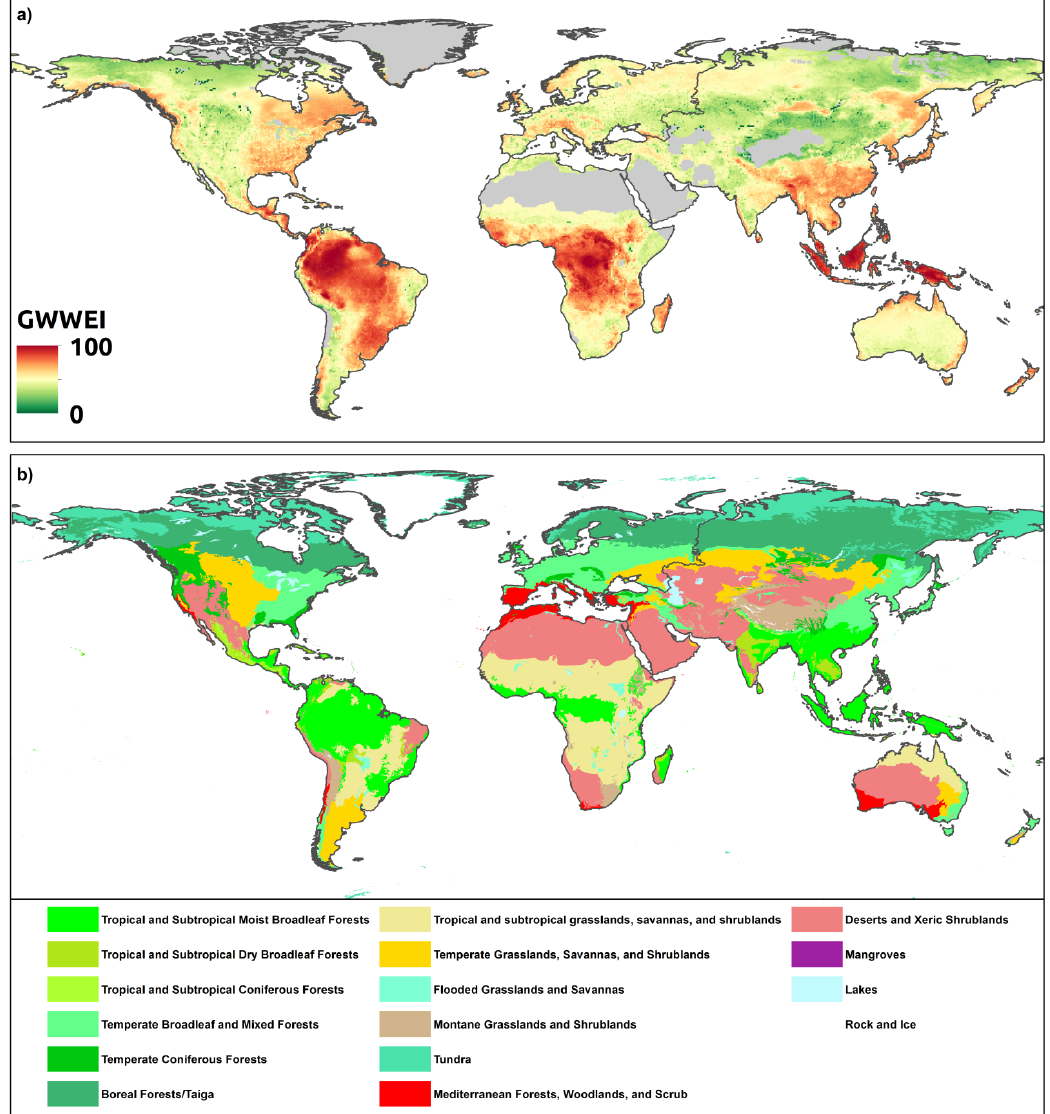
Figure 3. ( a ) Map of the global GWWEI as provided by additive aggregation. The index is dimensionless; scores stretched to 0–100. Higher values (100, dark red) mean a higher concentration of risk factors. ( b ) A map of terrestrial biomes [49] is also provided for comparison purposes (see Section 3.1).